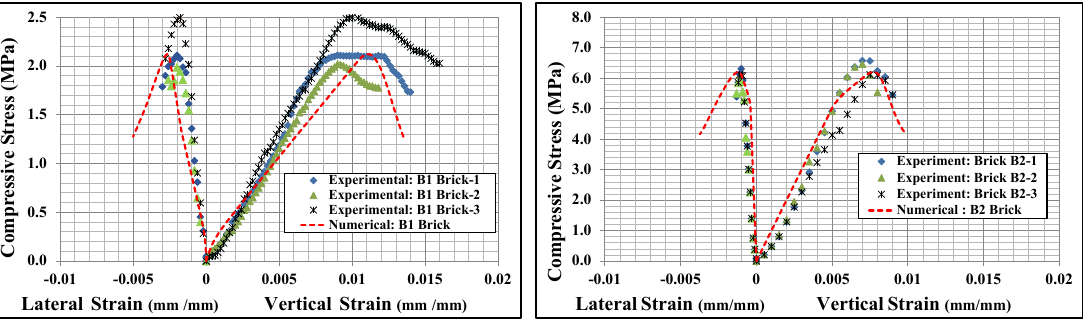
Figure 8. Stress-strain responses of the wallettes under monotonic compression test; ( a ) B1 and ( b ) B2 wallettes.